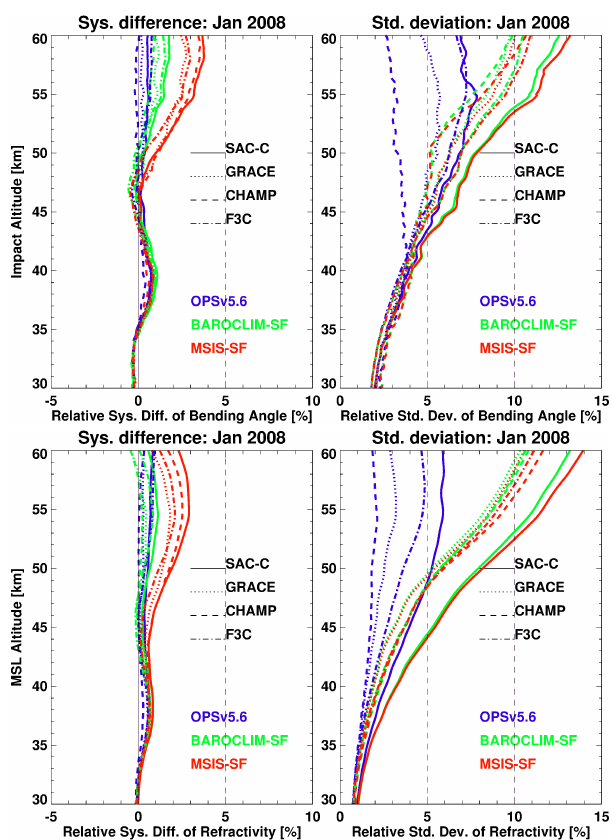
Figure 7. Global statistics of systematic difference (left) and stan- dard deviation (right) between RO retrievals and ECMWF analy- ses for January 2008. The top panels show (statistically optimized) bending angle, and bottom panels refractivity. Different line types indicate retrievals for SAC-C, GRACE-A, CHAMP, and F3C. Dif- ferent colors different indicate a priori information used in the re-